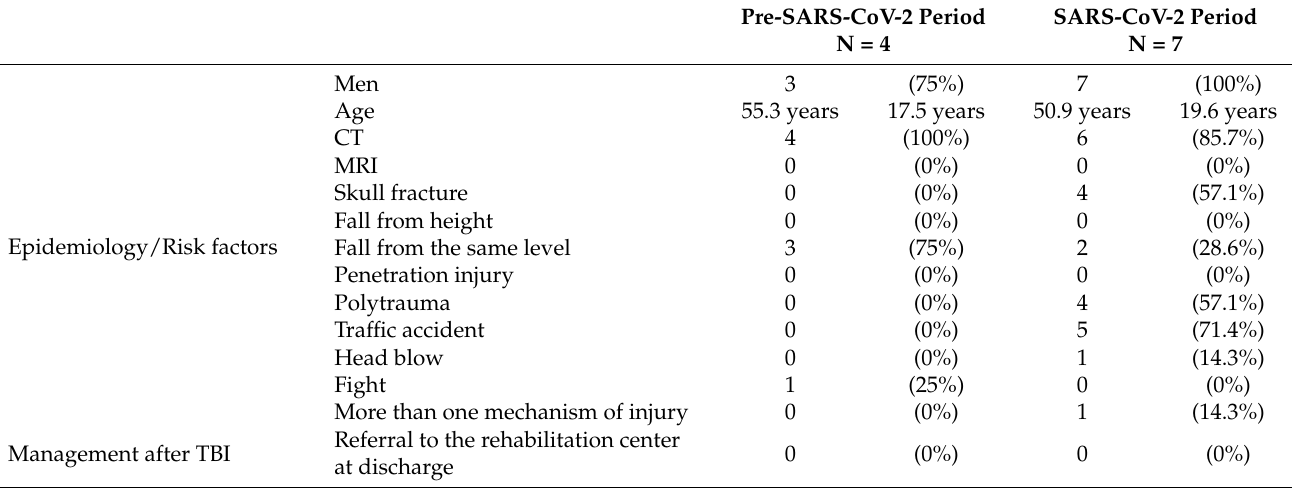
Table 3. Epidemiology and management of patients with severe